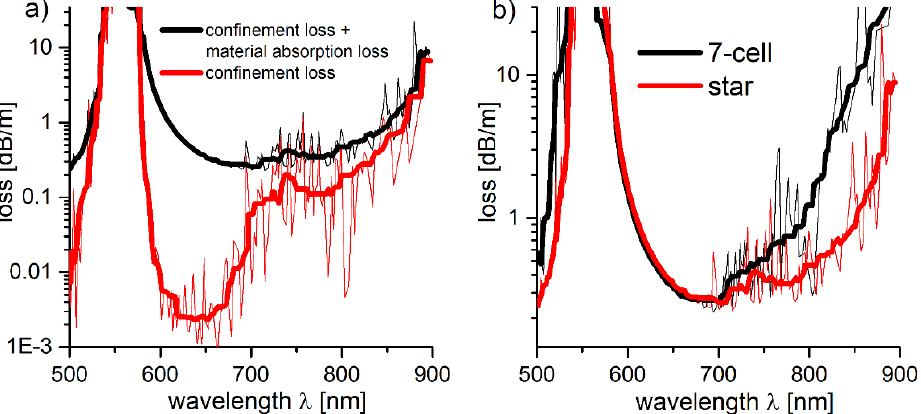
Figure 12. ( a ) Comparison of the loss (confinement loss + material absorption loss, black line) and confinement loss spectra (red line) of the star structure based on PMMA. The loss increase is visible, particularly in the 600–700 nm region, which suggests that the total loss here is influenced mainly by the PMMA material absorption. ( b ) Loss spectra of the PMMA-based 7-cell and star structures (black line and red line, respectively). In the 600–700 nm spectral region the influence of the material absorption loss is large enough to negate the confinement loss decrease of the star structure. As the wavelength increases, the latter again starts to outperform the 7-cell one.